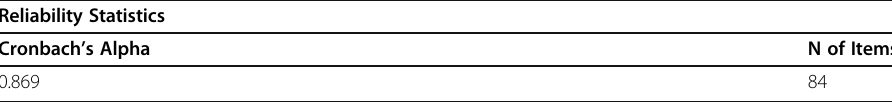
Table 2 Cronbach ’ s